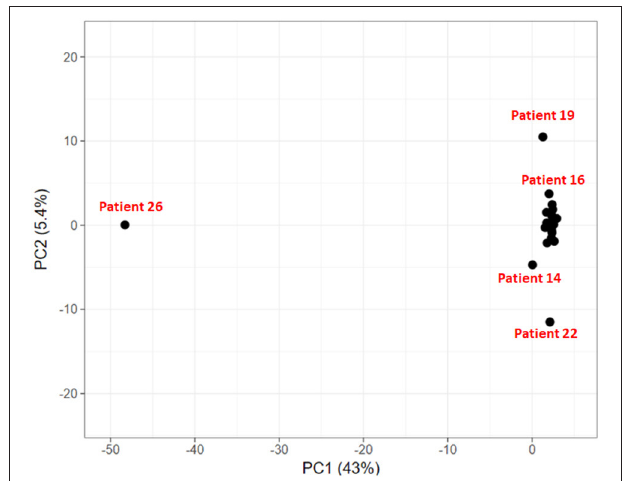
FIGURE 6 | Clustering of HCC patients based on somatically mutated